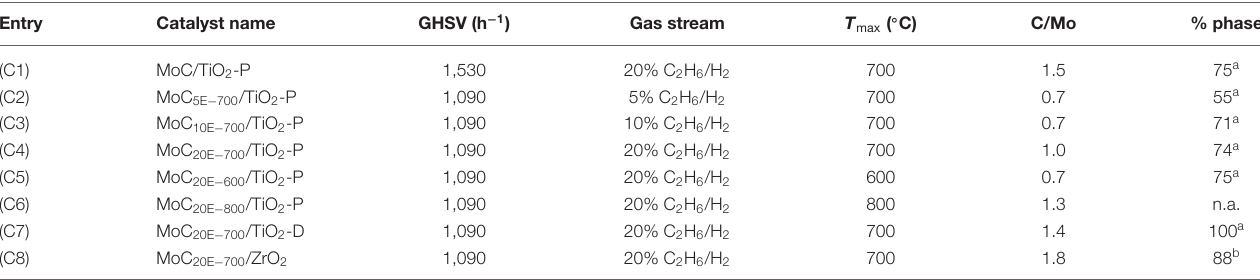
TABLE 1 | List of the supported molybdenum carbide catalysts synthesized from C 2 H 6 /H 2 , with the corresponding preparation conditions, the C/Mo atomic ratio derived from elemental analyses, and the support composition (%